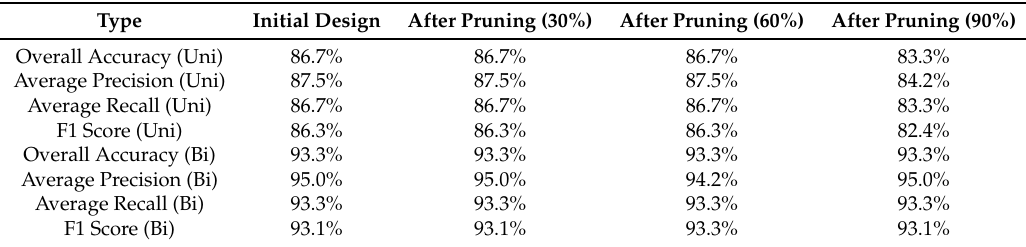
Table 3. Performance of Pruning